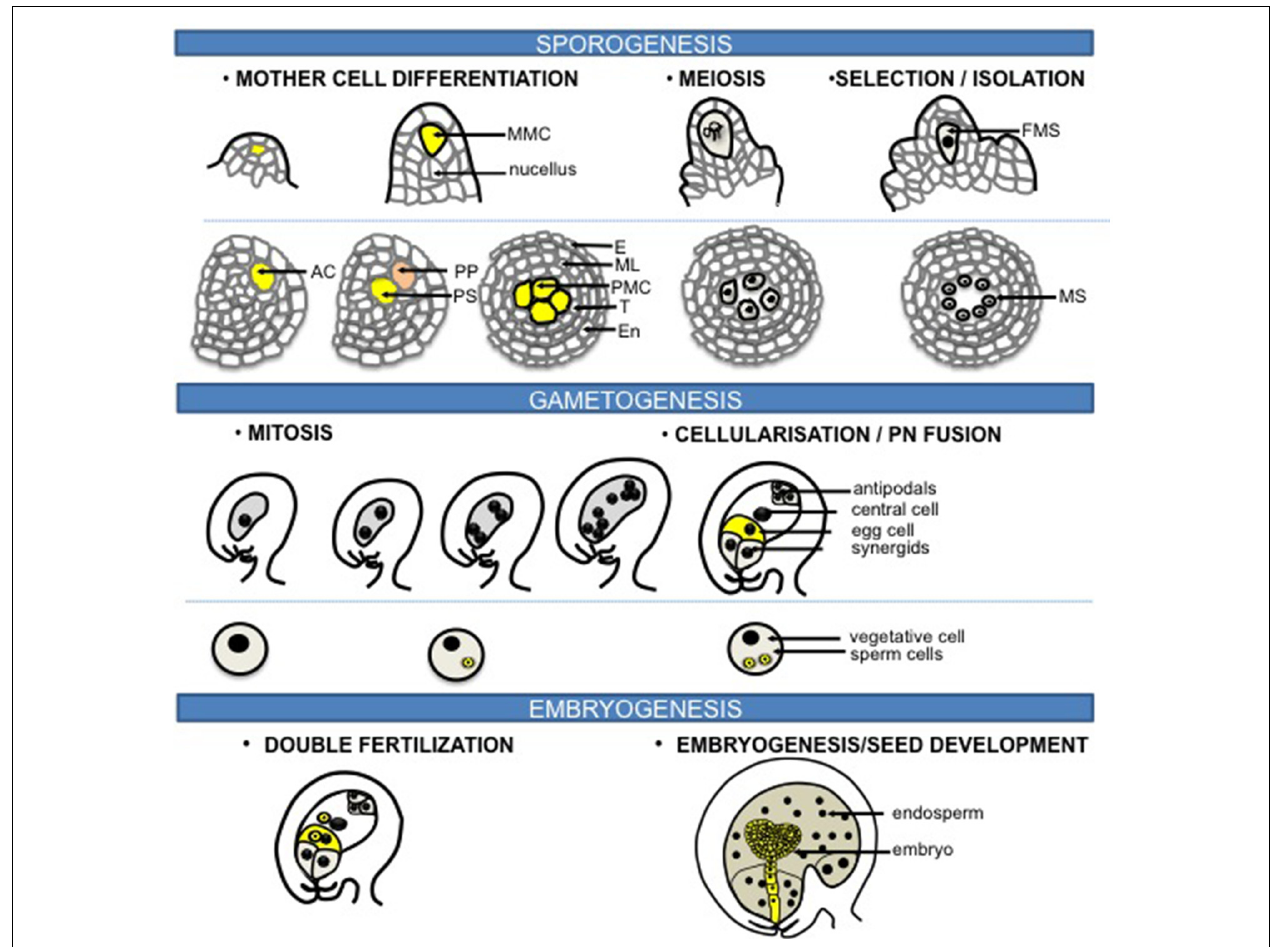
FIGURE 1 | Sexual reproduction in flowering plants. The process of sexual reproduction begins with sporogenesis where spore mother cells (SMCs) differentiate in the floral organs of adult plants. The female SMC, also called megaspore mother cell (MMC) differentiates from a subepidermal nucellar cell within the ovule primordium, the MMC then undergoes meiosis to produce four haploid spores while only one survives to form the functional megaspore (FM). In the stamen primordium, one subepidermal cell enlarges to from the archesporial cell (AC). The archesporial cell then divides to form one primary sporogenous cell (PS) on the inner side and one primary parietal cell (PP) toward the outside. The primary parietal cell divides periclinally and anticlinally to generate the anther wall that is composed of epidermis (E), endothecium (En), the middle layer (ML), and the tapetum (T), while the primary sporogenous cell divides to give rise to the male SMCs,